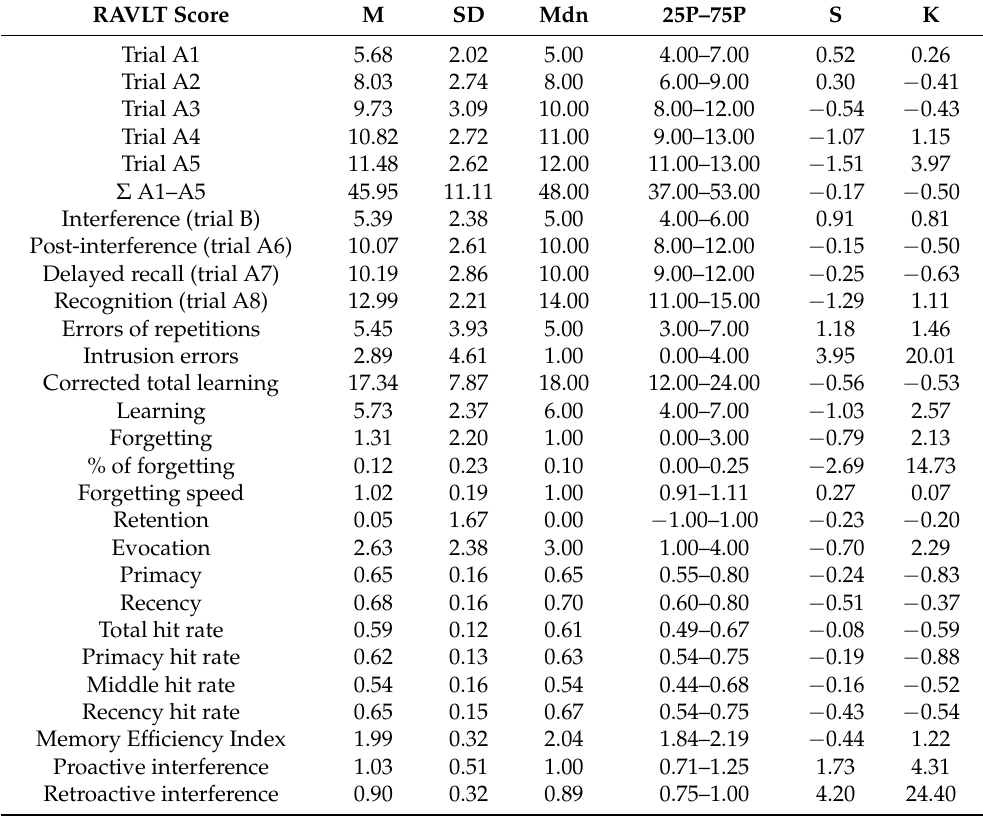
Table 3. Postpartum women’s performance in the Rey Auditory Verbal Learning Test ( n =